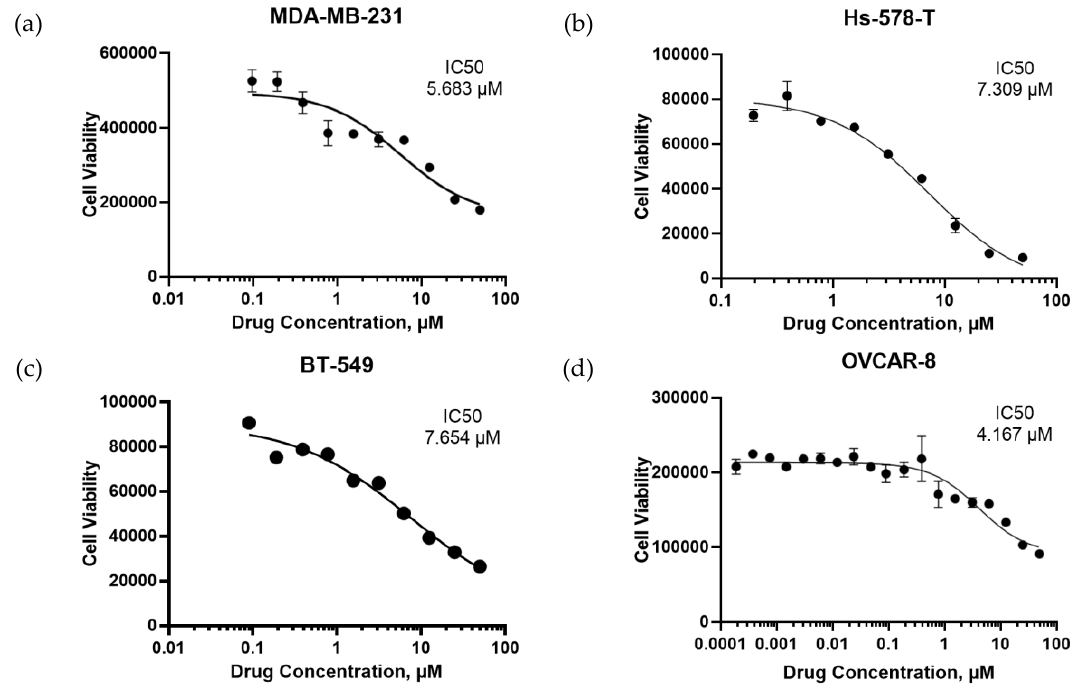
Figure 5. Cell death activity of NSC243298 in cancer cell lines. ( a ) MDA-MB-231 cells. ( b ) Hs-578-T cells. ( c ) BT-549 cells. ( d ) OVCAR-8 cells.